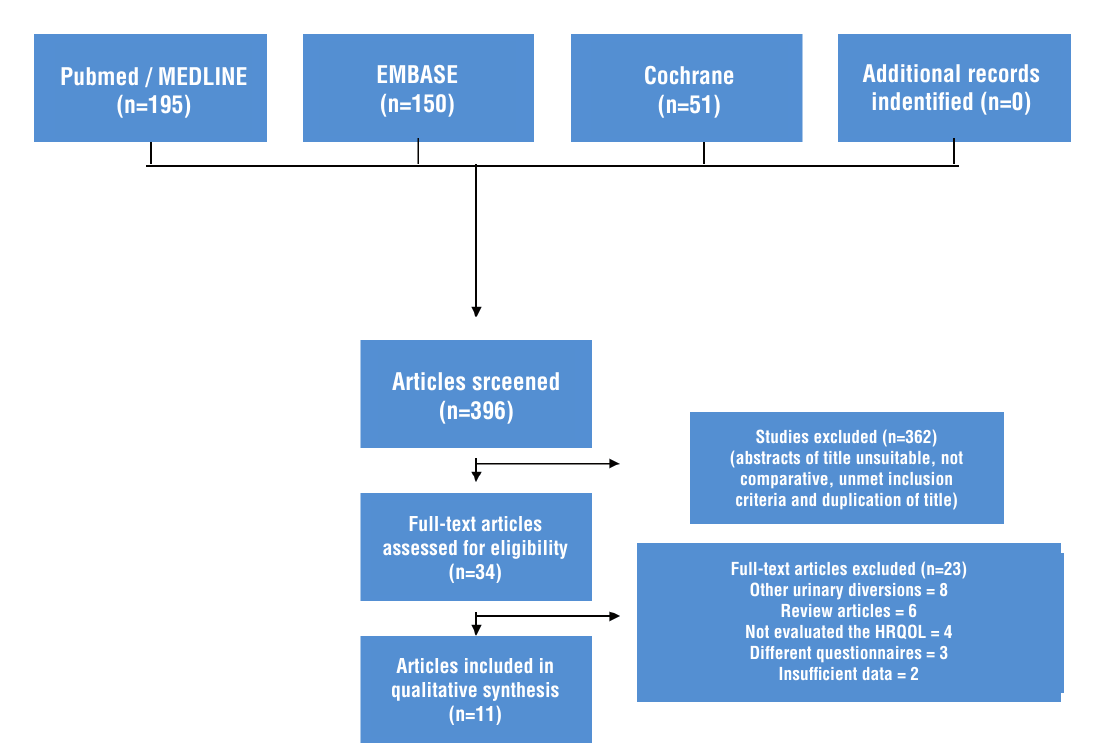
Figure 1 - PRISMA fl